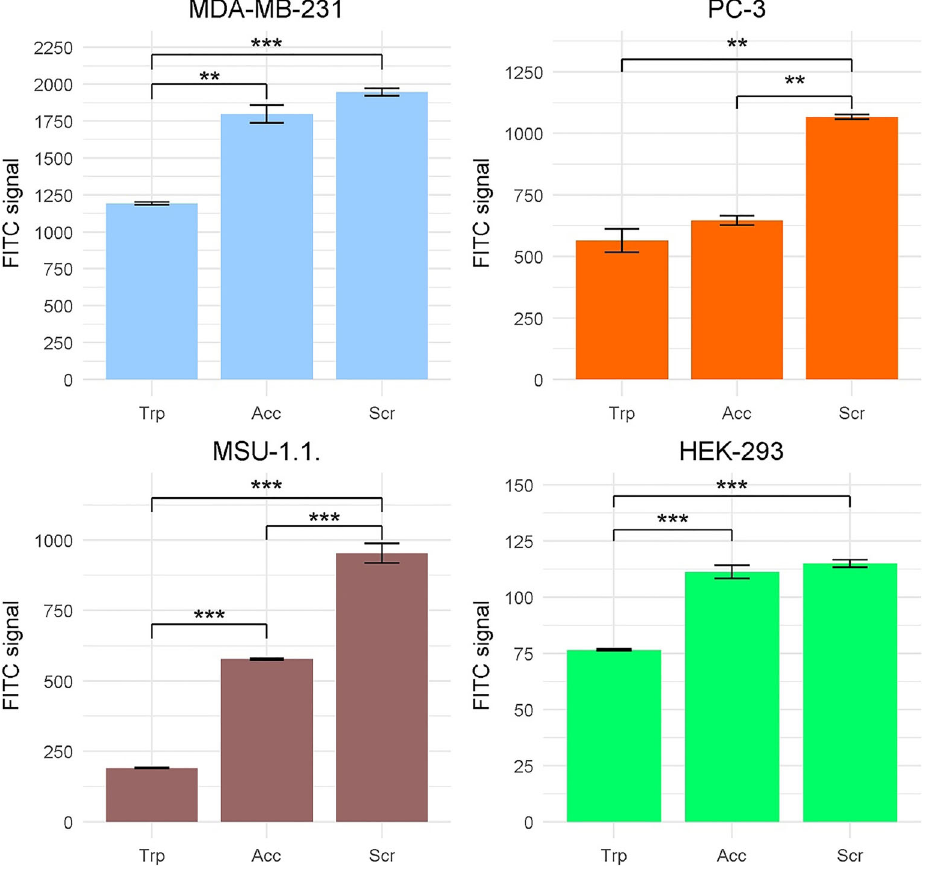
Figure 3. Summarized results of the CD55 level analysis in different cell lines using different harvesting methods [trypsin (Trp), accutase treatment (Acc), scraping by rubber scraper (Scr)]. Data are reported as means ± SD. **P o 0.01, ***P o 0.001 (ANOVA and Tukey ’ s HSD